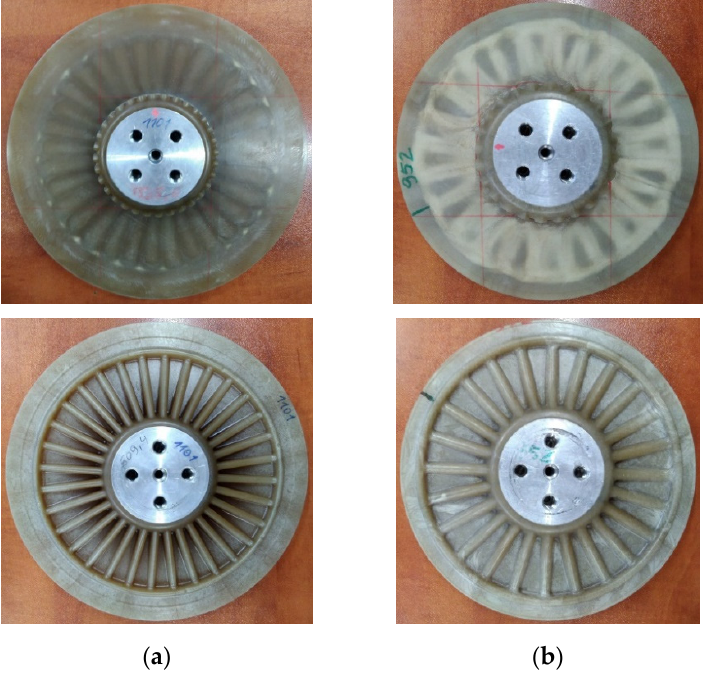
Figure 3. The top and bottom views of the tested disks: ( a ) The larger disk; ( b ) The smaller disk.